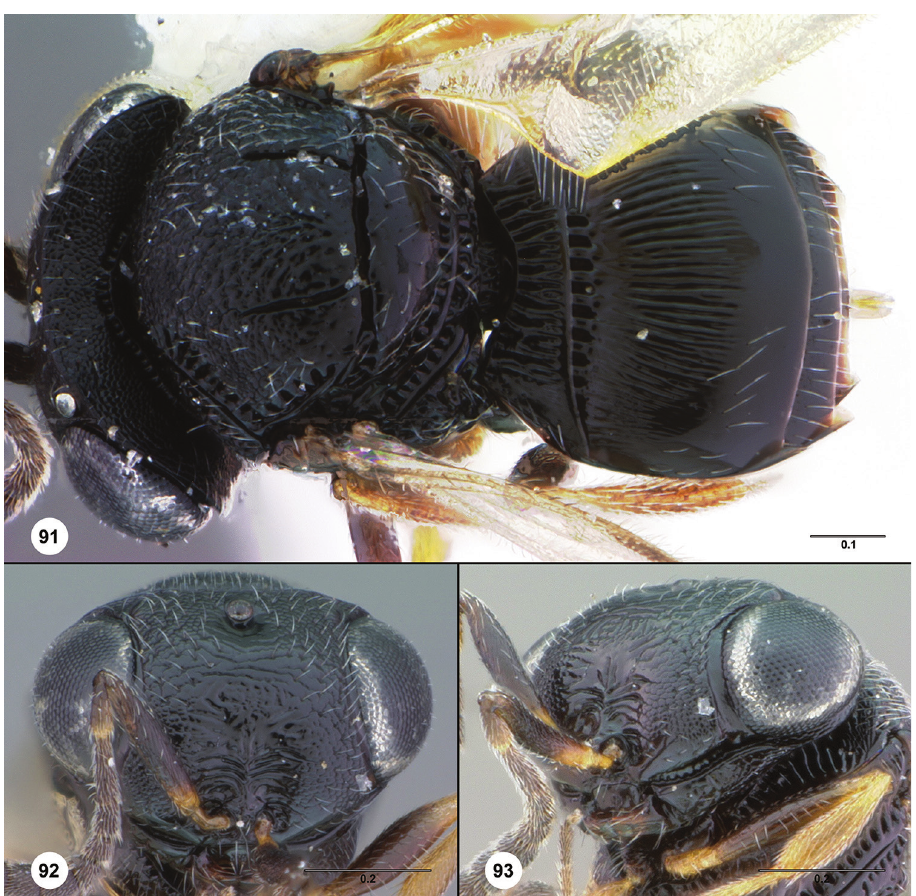
Figures 91–93. Trissolcus kozlovi 91 female (USNMENT00916624), head, mesosoma, metasoma, dor- sal view 92 female holotype (ZMAS 0147), head, anterior view 93 female holotype (ZMAS 0147), head, anterolateral view. Scale bars in millimeters. tion of posteroventral metapleuron: absent. Sculpture of dorsal metapleural area: smooth in anterodorsal corner, coarsely rugose posteriorly. Posterodorsal metapleural sulcus: poorly defined to absent. Paracoxal sulcus in ventral half of metapleuron: indistinguishable from sculpture to absent; indicated by a line of elongate cells. An- teroventral extension of metapleuron: extending to base of mesocoxa. Metapleural epicoxal sulcus: present as coarse rugae. Mesoscutal humeral sulcus: indicated by a line of cells. Median mesoscutal carina: absent. Macrosculpture of mesoscutum: rugulose, with oblique symmetryl in relation to longitudinal midline. Pattern of mesoscutal microsculpture: effaced posteriorly. Mesoscutal suprahumeral sulcus: comprised of cells. Length of mesoscutal suprahumeral sulcus: about half the length of anterolateral edge of mesoscutum. Parapsidal line: absent. Notaulus: extending